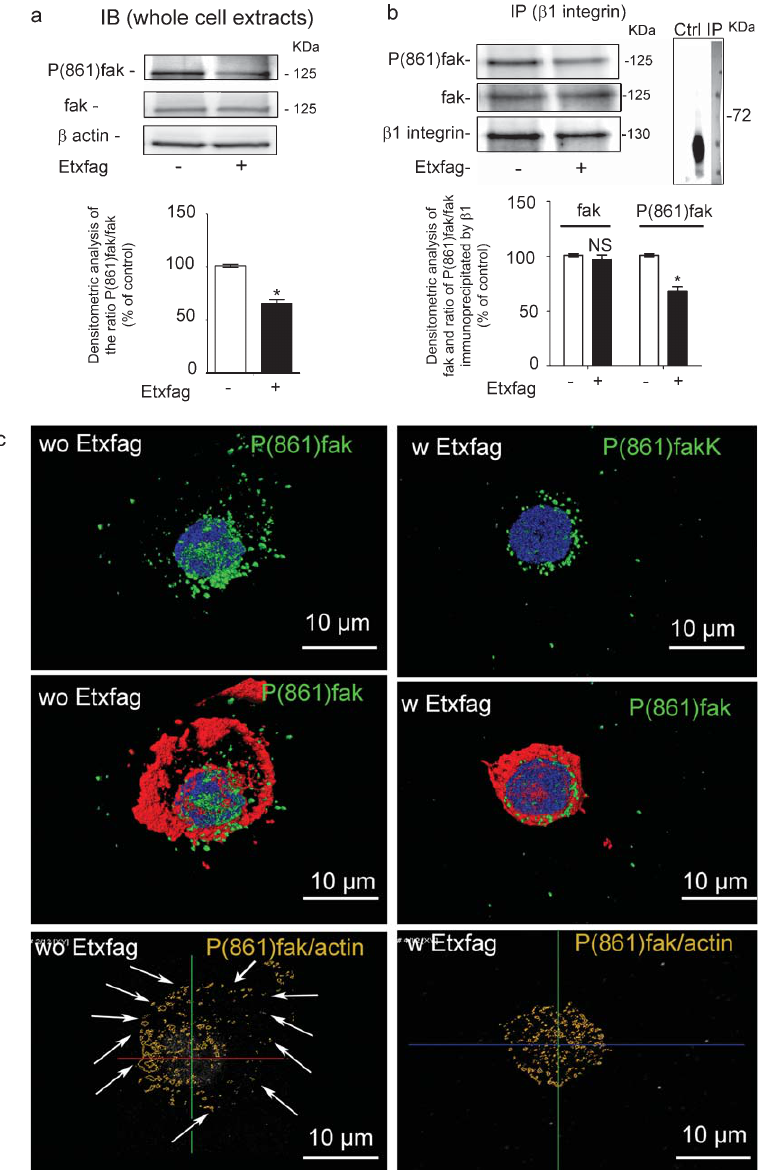
Fig. 5. Etxfag prevents fak phosphorylation on Tyr 861. a ) Whole cell lysates prepared from L1210 cells treated or not with 1 × 10 − 7 M etxfag during 24h were subjected to immunoblotting with anti-phosphorylated-Y861 fak and fak. A representative blot of three independent experiments was shown. Graph represents the densitometric analysis of the ratio P(861)fak/fak in control ( (cid:1) ) and treated ( (cid:2) ) cells * P <0.05. b ) Cell lysates prepared from L1210 cells treated or not with 1 × 10 − 7 M etxfag during 24h were immunoprecipitated with anti- (cid:1) 1 antibody and immunoblottedwithanti-phosphorylated-Y861-fakandfak.NonspecificIgGswereusedasnegativecontrolsofimmunoprecipitation(windows). A representative blot of three independent experiments was shown. Graph represents the densitometric analysis of the ratio P(861)fak/fak in control( (cid:1) )andtreated( (cid:2) )cells. c )L1210cellstreatedornotwith1 × 10 − 7 Metxfagfor24hwereseededtoFN/Vfor2h.Cellswerefixedwith paraformaldehyde 4% and permeabilized with 0.1% Triton X-100. Blue color represents nuclear staining with DAPI. Cells were labelled with anti-phosphorylated-Y861-fak and then with a secondary antibody linked to Alexafluor 488 (green). Cells were also incubated with Alexafluor 568-conjugated phalloidin (red) to visualize F-actin distribution. Surfacic reconstructions were realized from L1210 cells treated with or without etxfag (right and left row, respectively). Upper panels represent P(861)fak labelling, middle panels represent P(861)fak+F-actin labelling and